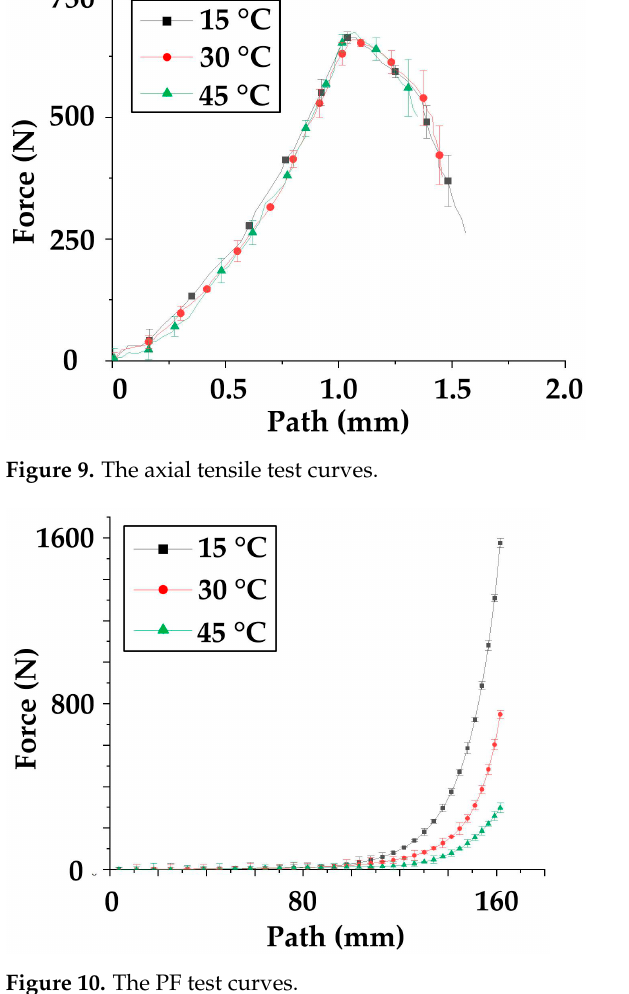
Figure 10. The PF test